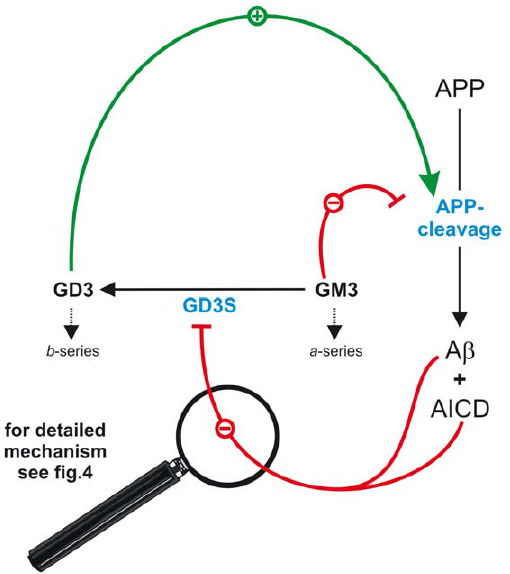
Figure 6. Hypothetic model of the physiological functions of A b and AICD in the regulation of GD3-synthase (GD3S) – the enzyme controlling major brain ganglioside composition. ( A ) Amyloidogenic proteolytic processing of the Alzheimer’s amyloid precursor protein (APP) releases amyloid-beta peptides (A b ) and the intracellular domain of APP (AICD). A b and AICD inhibit GD3S, resulting in reduced conversion of a - to b -series gangliosides. As a consequence of reduced conversion of a - to b -series gangliosides, GM3 increases whereas GD3 decreases. In return, both gangliosides, GM3 and GD3, themselves regulate the proteolytic cleavage of APP. The b -series ganglioside GD3 increases, whereas the a -series gangliosides GM3 decreases amyloidogenic proteolytic processing of